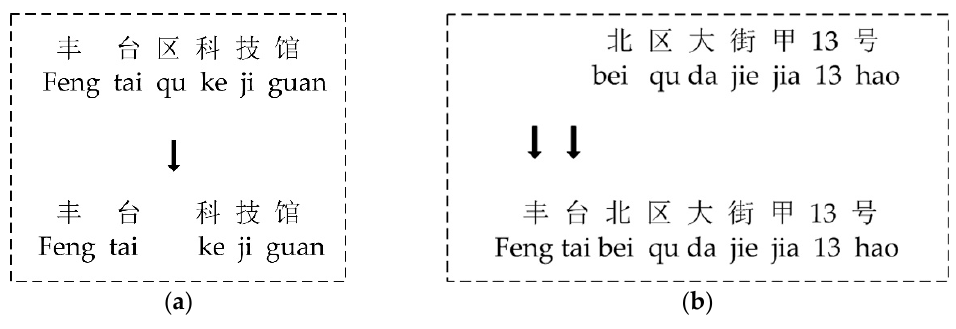
Figure 2. Calculating the Levenshtein distance—( a ) name Levenshtein distance and ( b ) address Levenshtein distance.